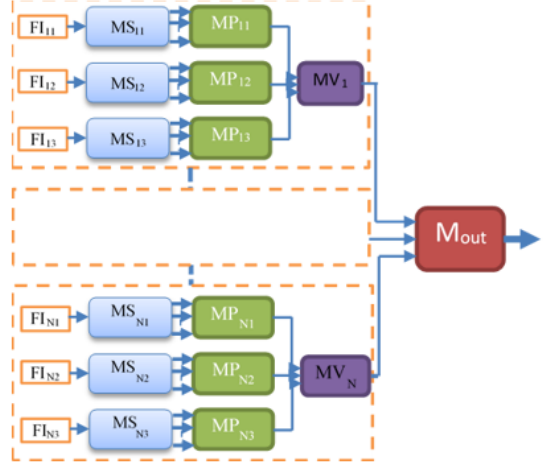
Figure 9. Block diagram of MFMPF model.